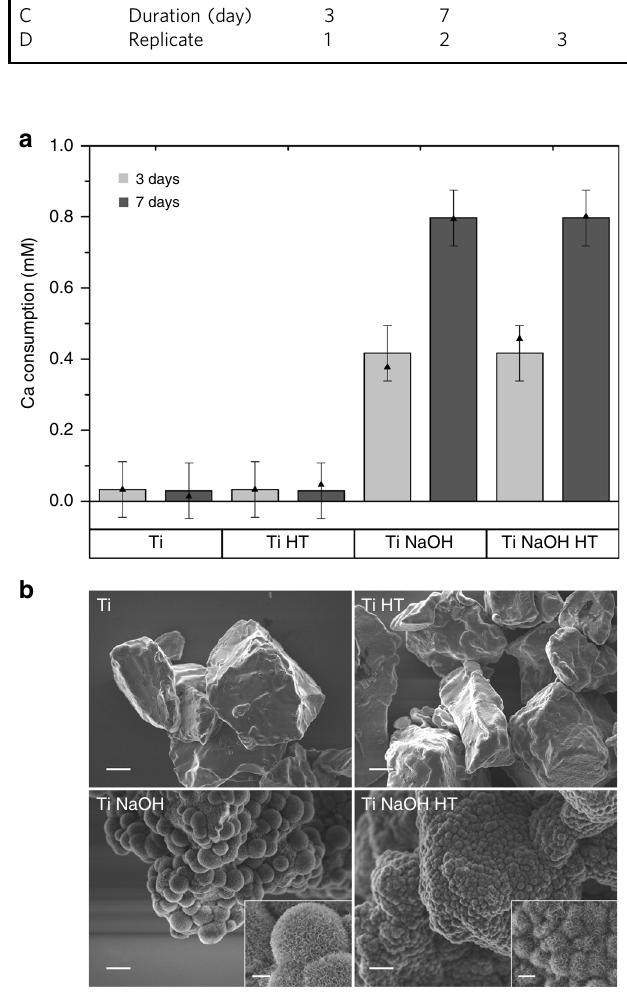
Fig. 5 Apatite formation on different Ti surfaces. a The amount of calcium depletion at 3 and 7 days for different powders. The free calcium content is measured with Ca ISE and normalized with standard SBF solution with known concentration to obtain the depleted Ca. The column chart is obtained based on the fi tted values using statistical analysis on the original data of three repetitions using distinct samples adopting a type I error risk of 5%. A 95% con fi dence interval is also given. The solid triangles give the experimental mean values based on three replicates. NaOH treatment and time duration are found to be statistically signi fi cant factors but not the heat treatment. b SEM images of Ti, Ti HT, Ti NaOH, and Ti NaOH HT after